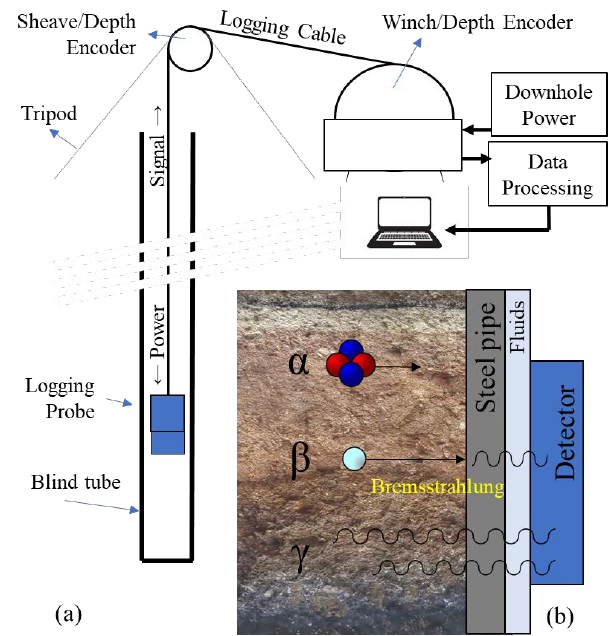
Figure 1 – A schematic diagram of a (a) blind-tube radiation sensing and downhole deployment system to (b) detect gamma and energetic beta emitting radionuclides (via produced bremsstrahlung photons) present in the surrounding soil formation (but close to the blind-tube). Alpha and beta low- energy emitting radionuclides are out of the scope of